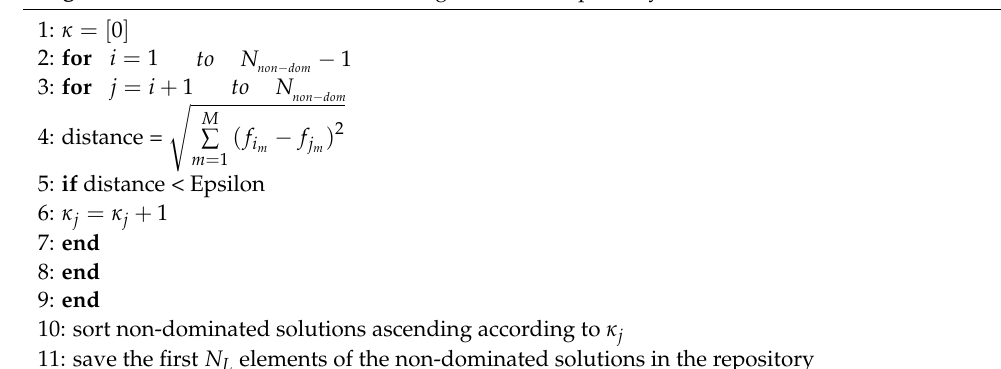
Algorithm 1. Pseudo code for controlling the size of